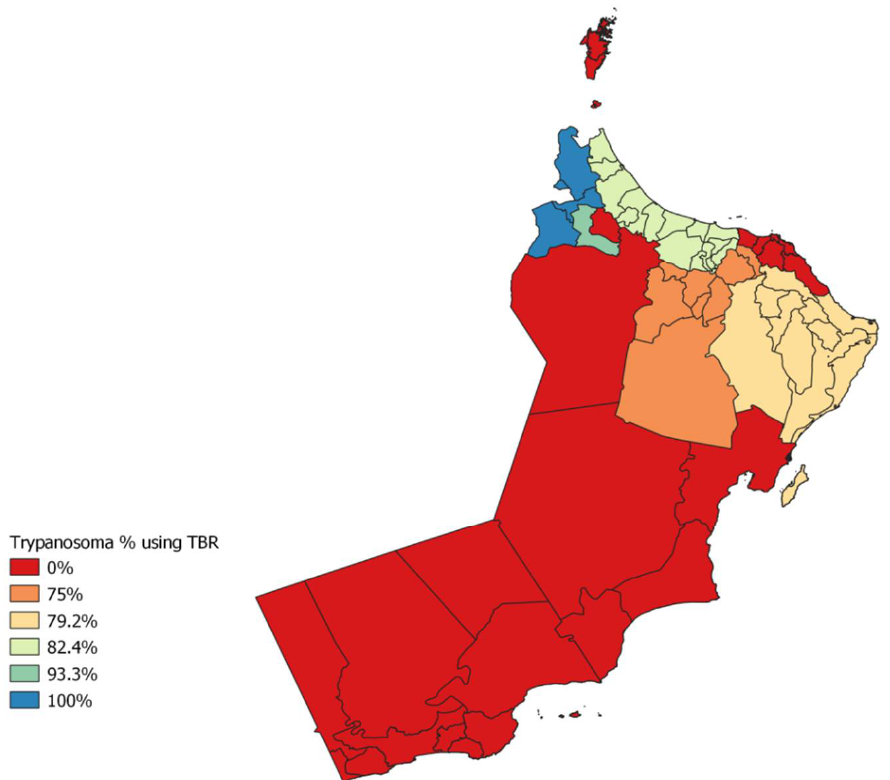
Figure 2. Distribution of trypanosomoses in camels in Oman by using TBR (QGIS 7.4).